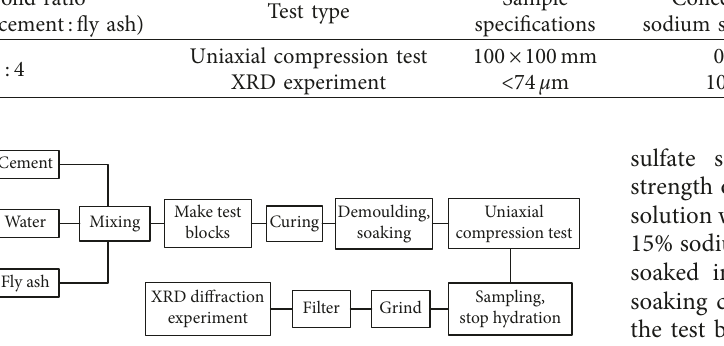
Figure 1: Experimental operation flow chart.